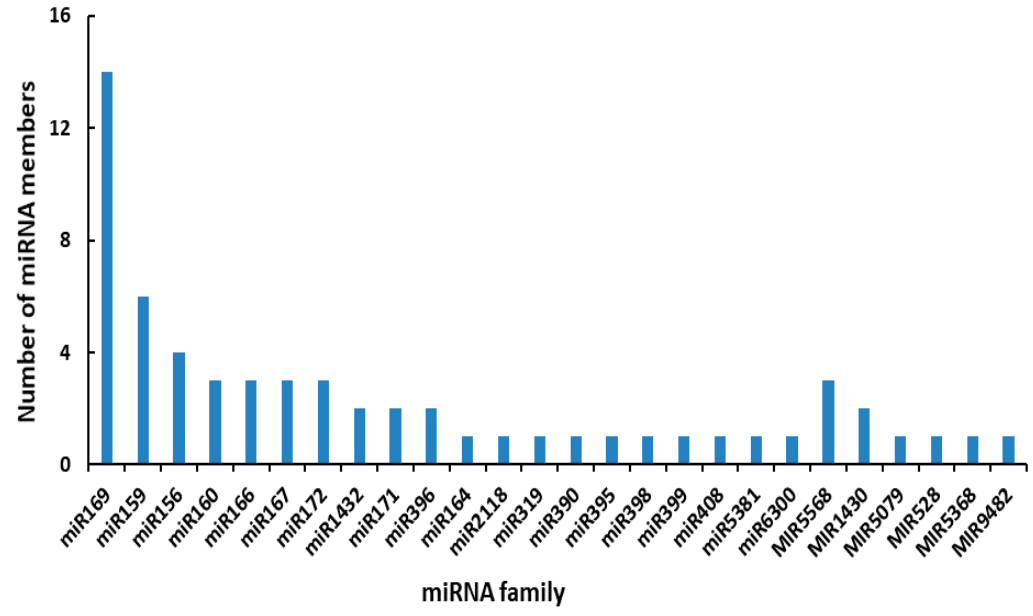
Figure 3. Number of DEMs member in each miRNA family.